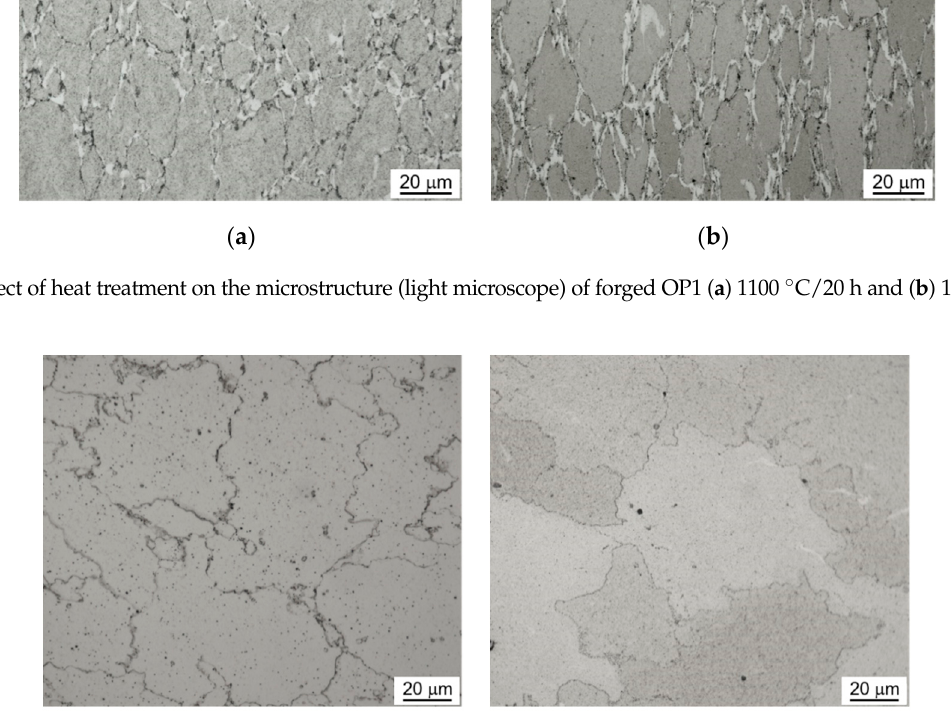
( b ) Figure 7. Effect of heat treatment on the microstructure (light microscope) of forged OP2 ( a ) 1100 °C/20 h and ( b ) 1200 °C/20 h.